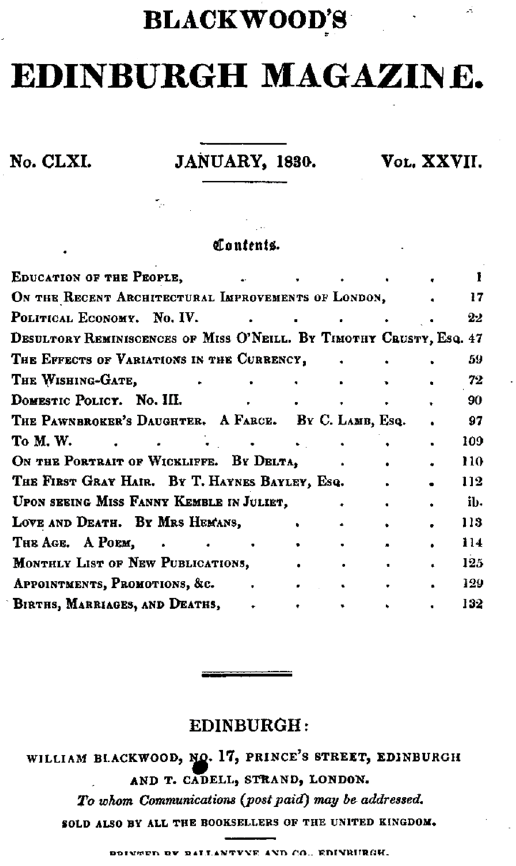
Figure 4. Blackwood’s Table of Contents. Available online: https://archive.org/details/sim_black-